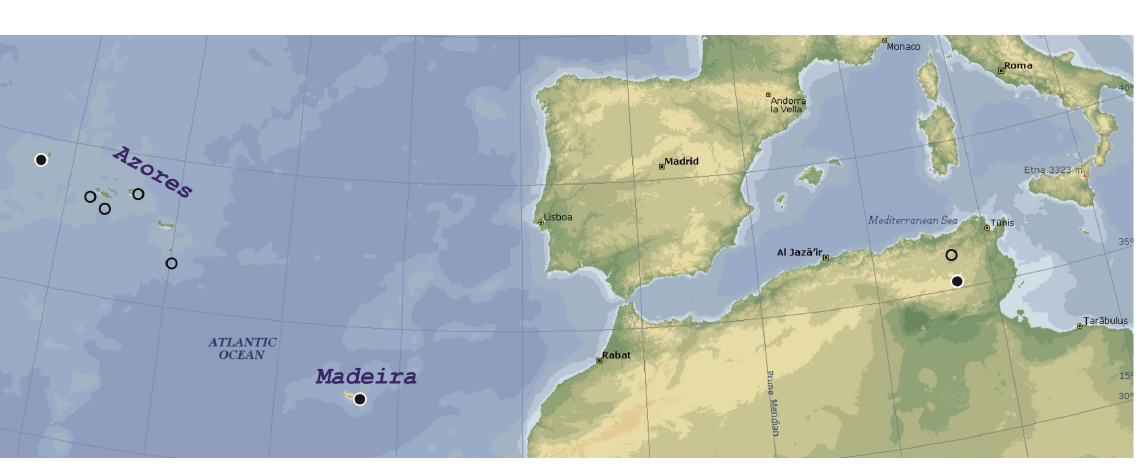
Fig. 5. Geographic distribution of Eucyclops azorensis Defaye & Dussart, 1991. Filled black